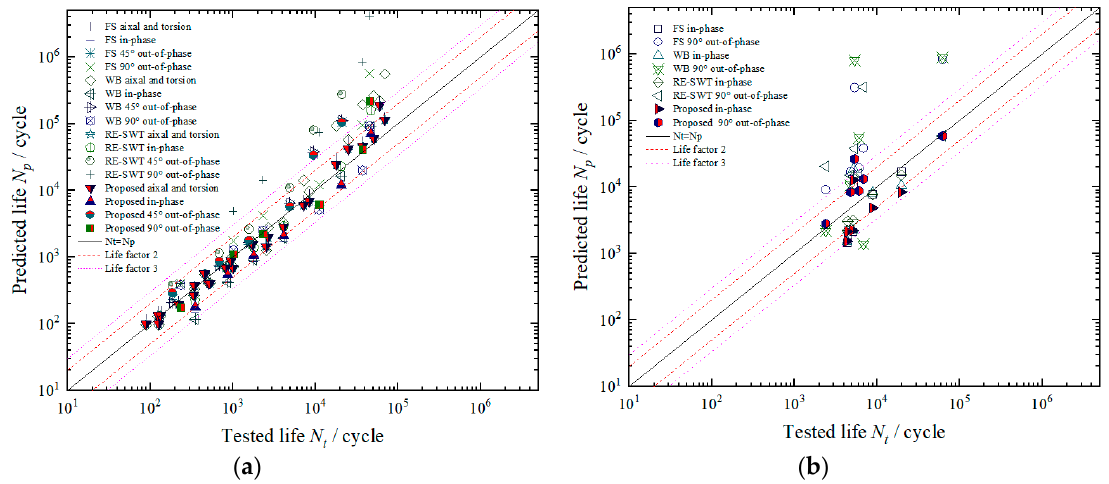
Figure 7. Fatigue life comparison of TC4 under symmetric and asymmetric loadings: ( a ) TC4 under symmetric loading; ( b ) TC4 under asymmetric loadings.